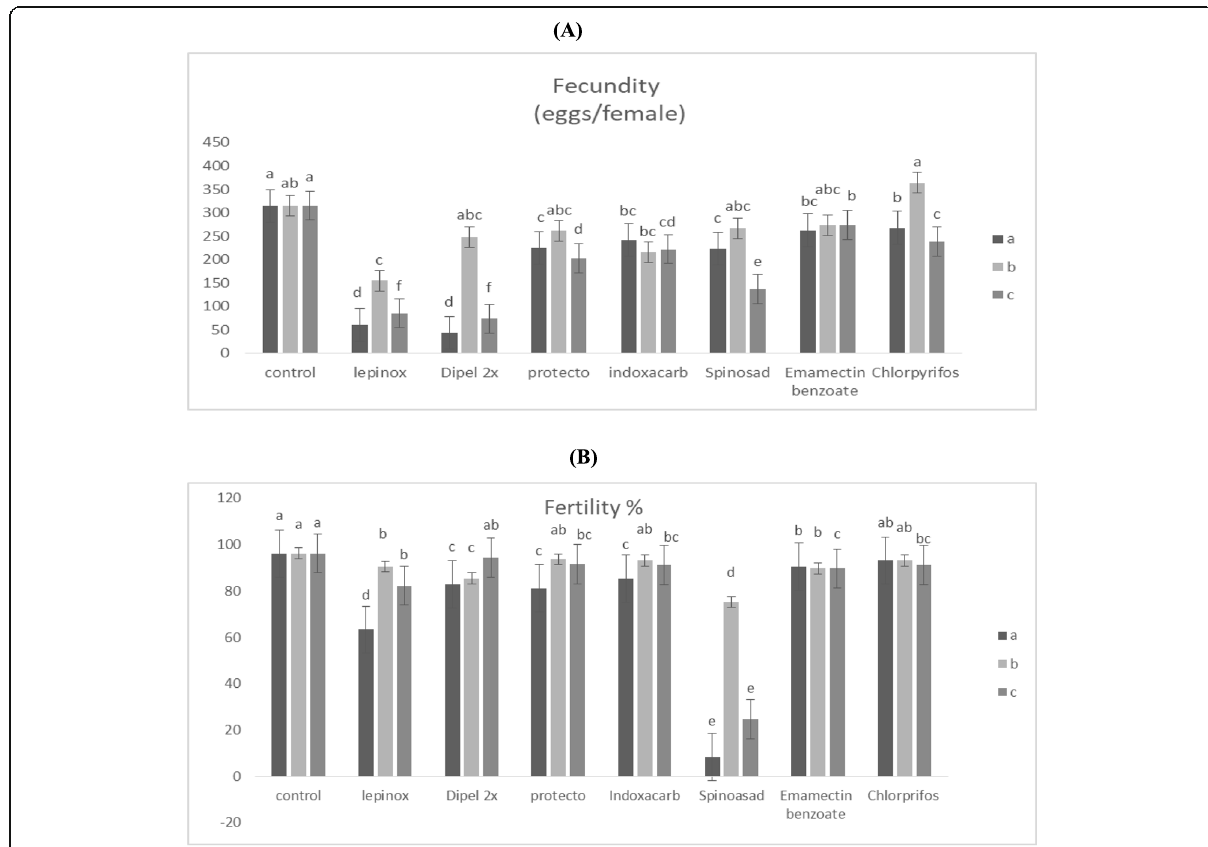
Fig. 1 Mean ± SE of fecundity (eggs/female) ( a ) and fertility % ( b ) of Tuta absoluta after treated the 2nd instar larvae to LC30 value of the tested bio-and chemical insecticides. a Mating group between treated female + treated male. b Mating group between treated female + untreated male. c Mating group between untreated female + treated male. Different letters on the bars of the histogram showed significant different between